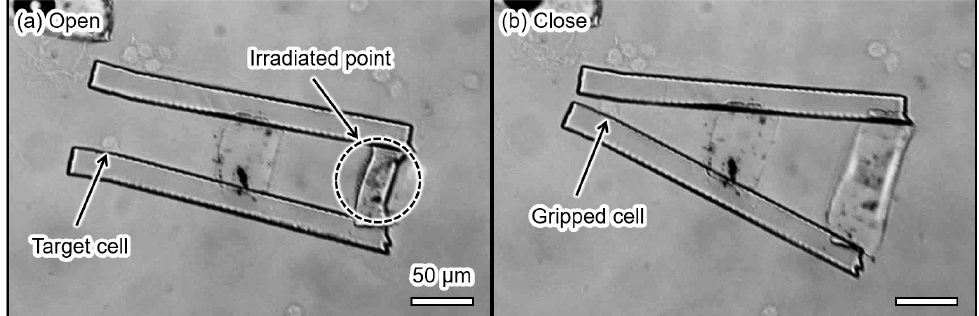
Figure 8. Microscopic images of MDCK gripping by the microgripper ( a ) before gripping and ( b ) during